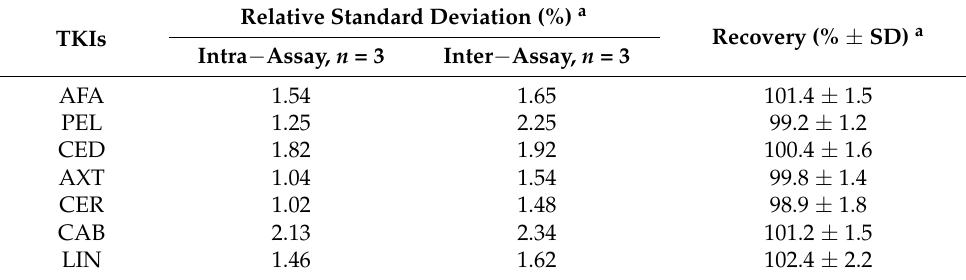
Table 7. Precision and accuracy of the proposed MW-SPA for TKIs via their CT reactions with iodine. TKIs